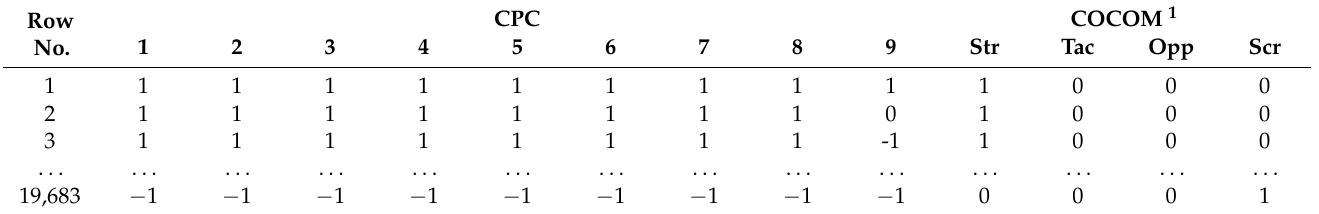
Table 5. A part of the conditional probability table (CPT).